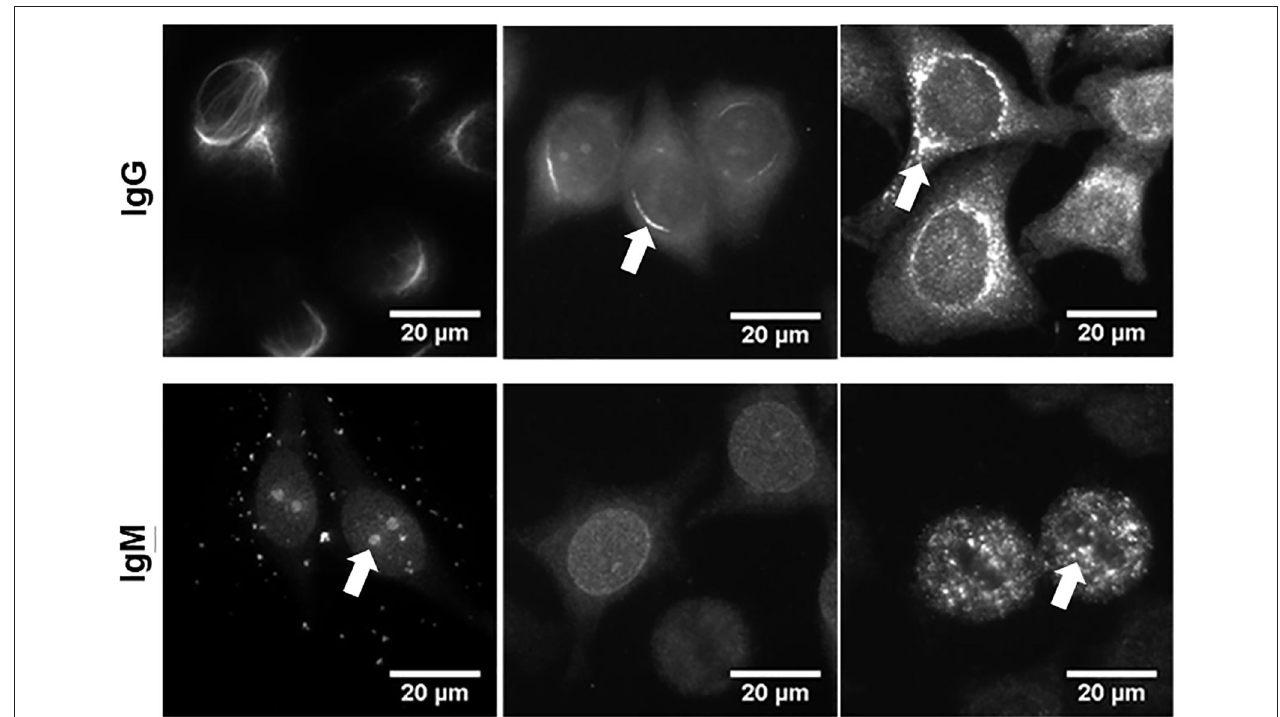
FIGURE 4 | Monoclonal antibodies derived from splenic B cells of septic mice bind several cellular self-antigens. Ten or 14 days after CASP induction, splenocytes were isolated and fused with myeloma cells to obtain hybridomas. Supernatants of monoclonal IgM- or IgG-producing hybridomas were incubated on HEp-2-ANA slides to detect auto-reactivity. Bound IgG or IgM was detected by FITC-labeled anti-mouse IgG or IgM antibodies. Three examples, respectively, of autoreactive monoclonal IgM- and IgG-antibodies are shown. The binding patterns of the various antibodies showed obvious differences, where in most cases more than one cellular structure was stained, albeit at varying intensities (indicated by arrows). For quantified data, regarding the numbers/percent of IgM or IgG hybridoma supernatants from septic mice directed against self-antigens, please refer to Table 2 .